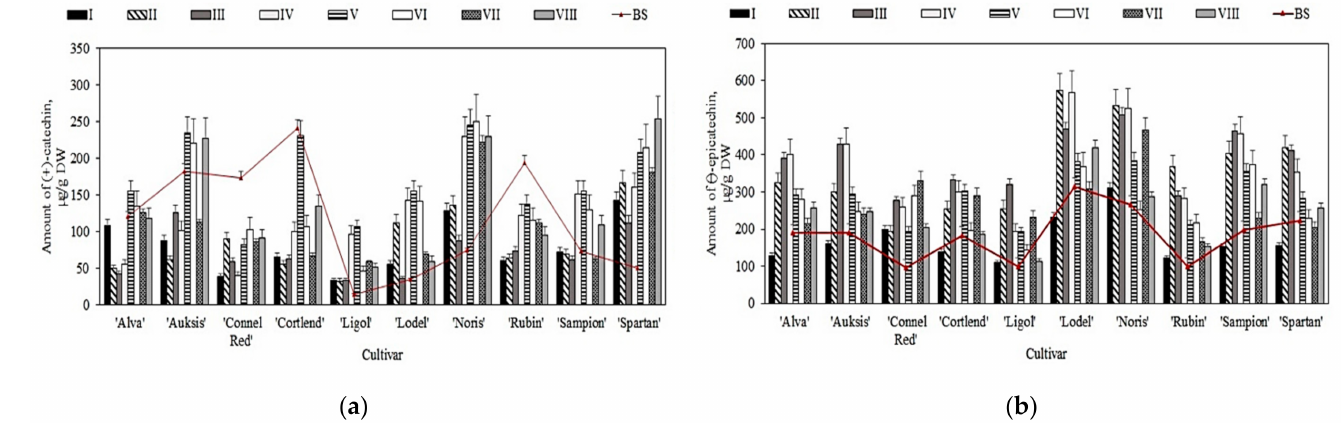
Figure 2. Changes in the amount of monomeric flavan-3-ols in whole apple samples before and after storage in controlled atmosphere: ( a ) Changes in the amount of (+)-catechin; ( b ) Changes in the amount of ( −